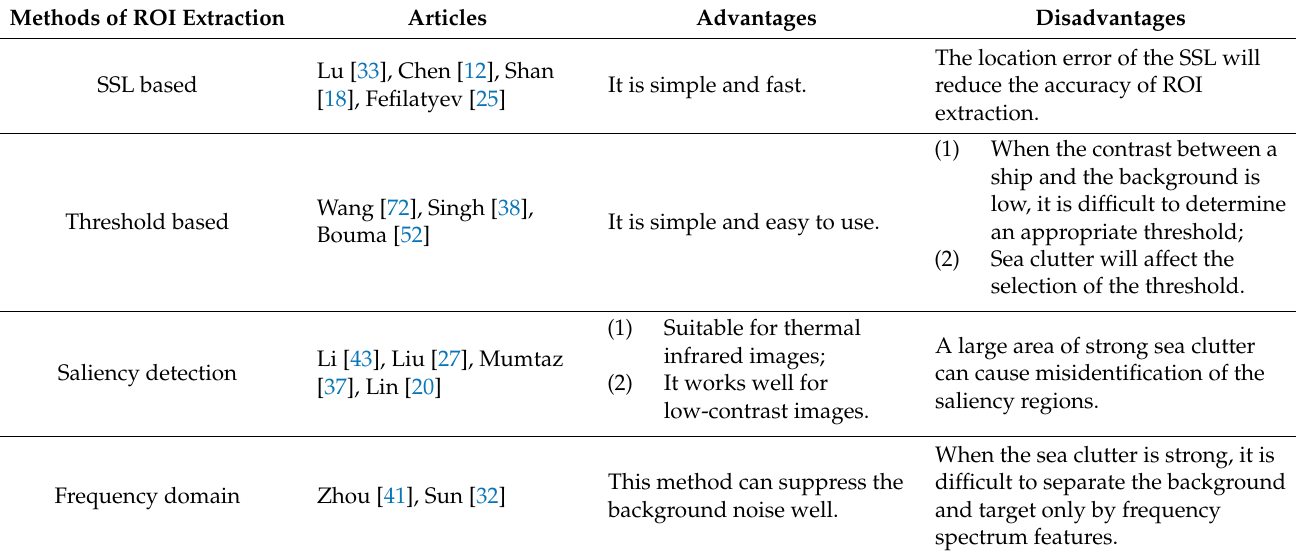
Table 4. Summary of the ROI extraction